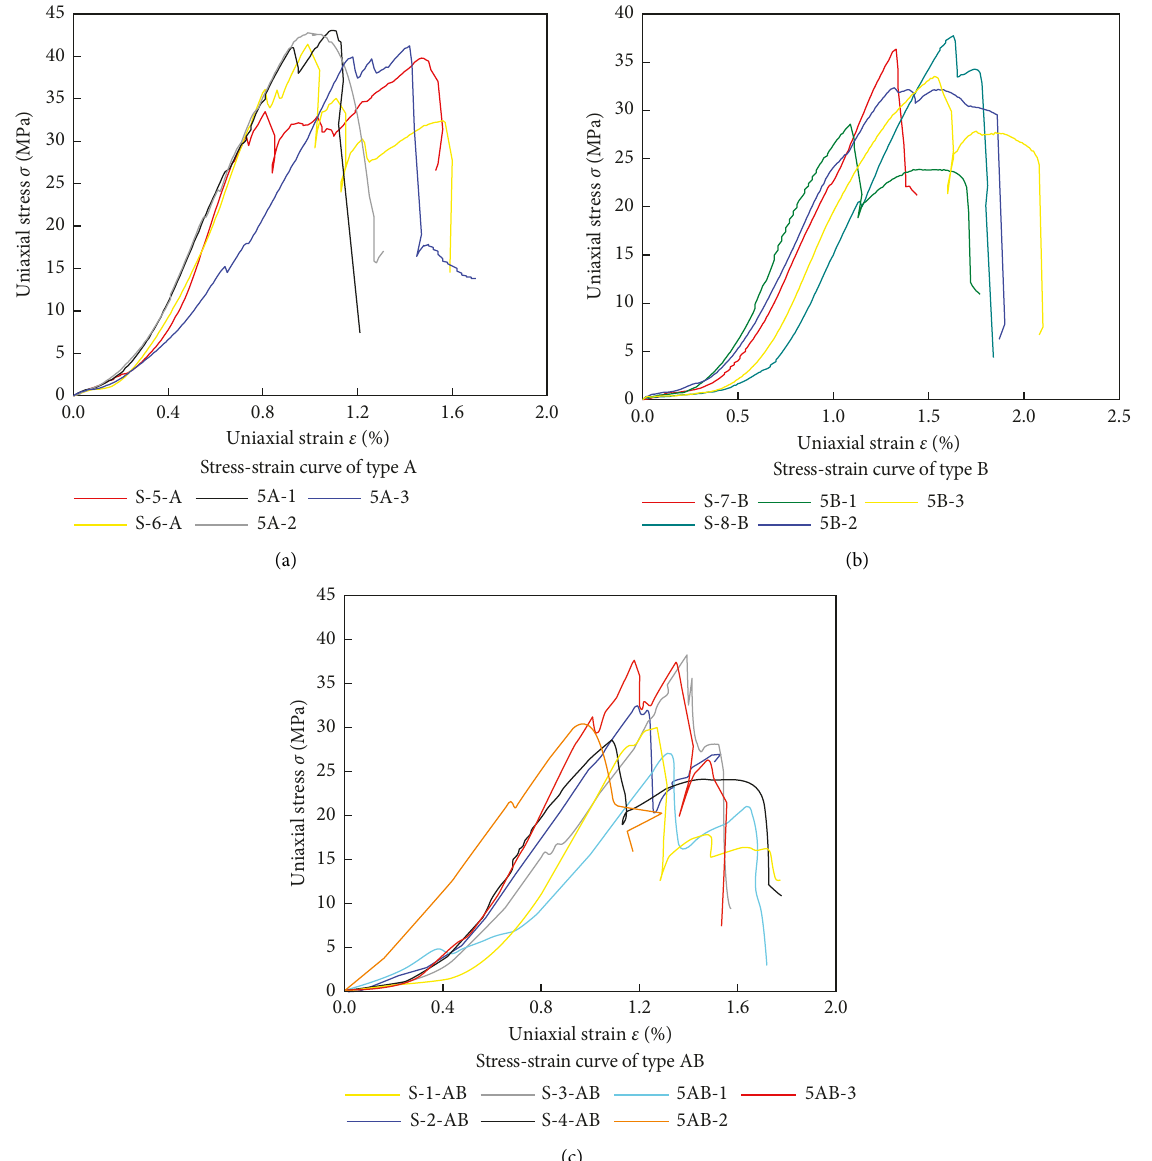
Figure 6: Stress-strain curve of rock. (a) Stress-strain curve of type A. (b) Stress-strain curve of type B. (c) Stress-strain curve of type